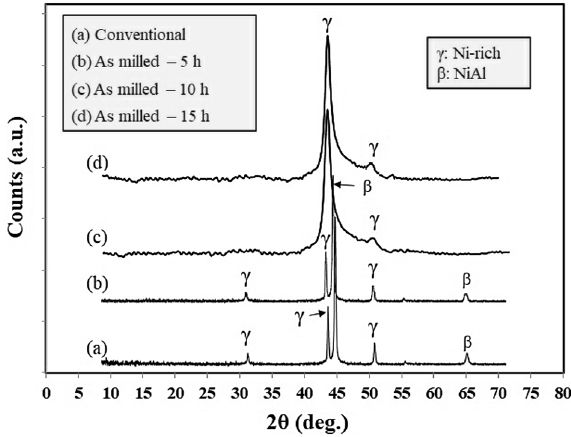
Figure 4. X-ray diffraction patterns of the commercial and mechanical-milled MCrAlY powders after 5, 10, and 15 h.